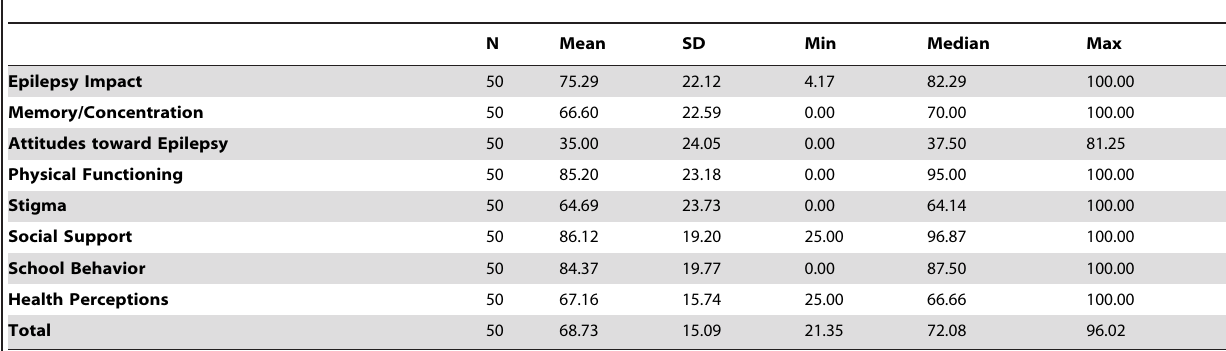
Table 1. Results of